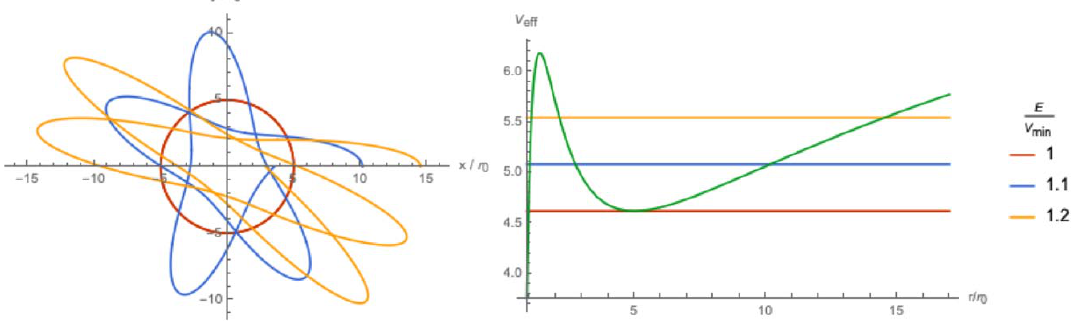
Figure 3 . Timelike geodesics obtained for the GR effective potential, where GM = 1 . 8 and L/r 0 =